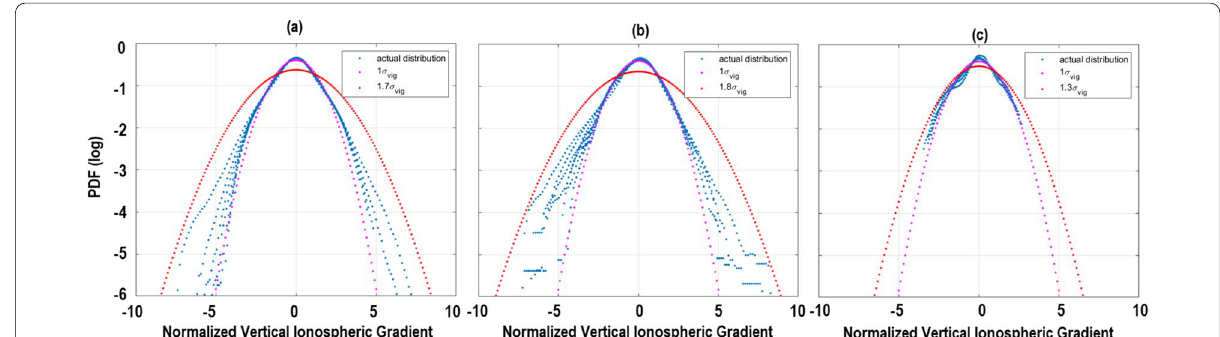
Fig. 5 Probability density of the occurrence of the ionospheric gradients normalized by the raw standard deviation for the data on 1 January 2013 as a result of a mixed-pair, b station-pair, and c satellite-pair